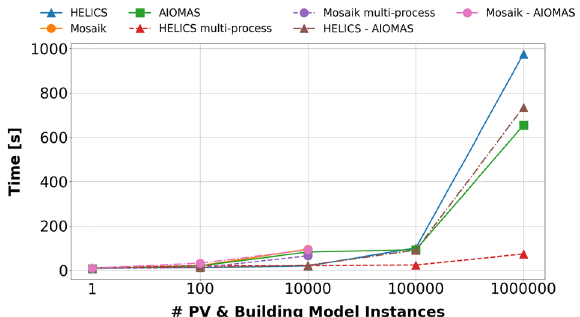
Fig. 10 Total execution time of the proposed Scenario for the different co-simulation frameworks and their